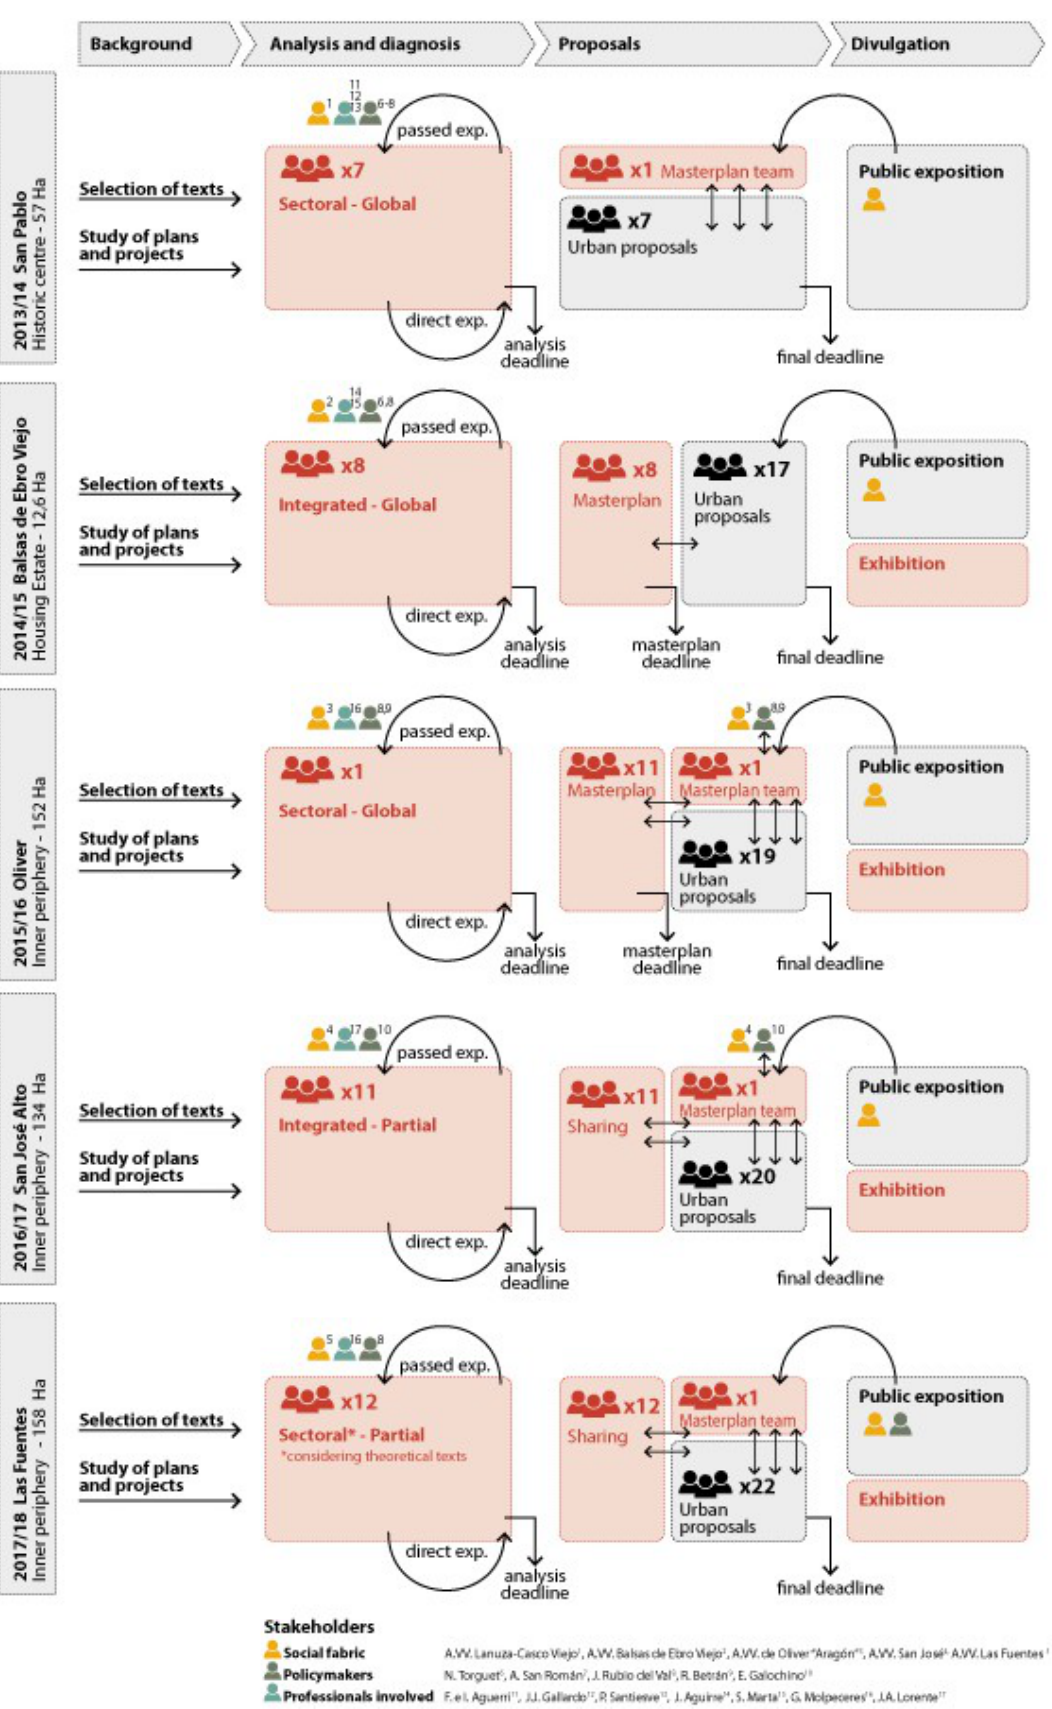
Figure 8. Methodological